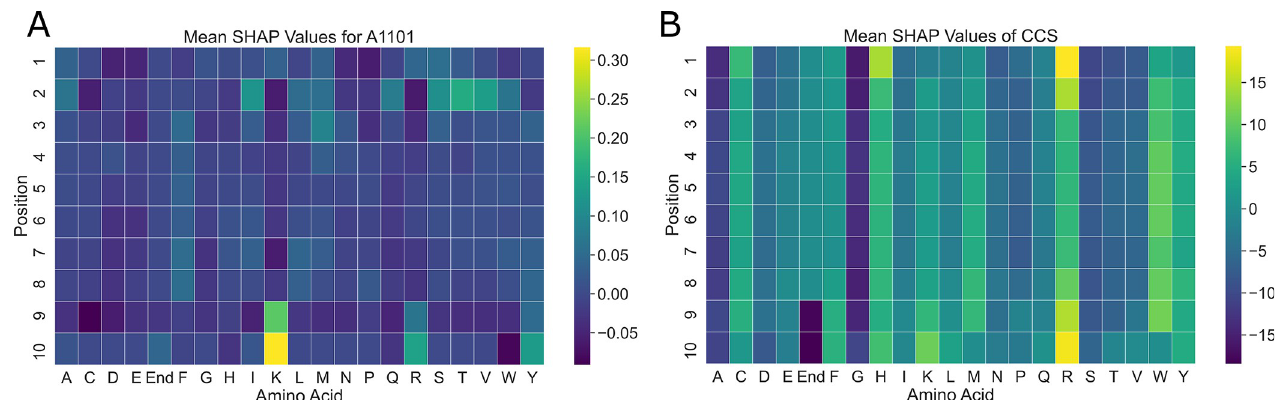
Fig 4. PoSHAP interpretation of models trained to predict A � 11:01 binding or CCS. The mean SHAP value for each amino acid across all test peptides were calculated and arranged into heatmaps representing the values for (A) A � 11:01 and (B) CCS. The position along the peptide is along the y-axis and each amino acid is listed along the